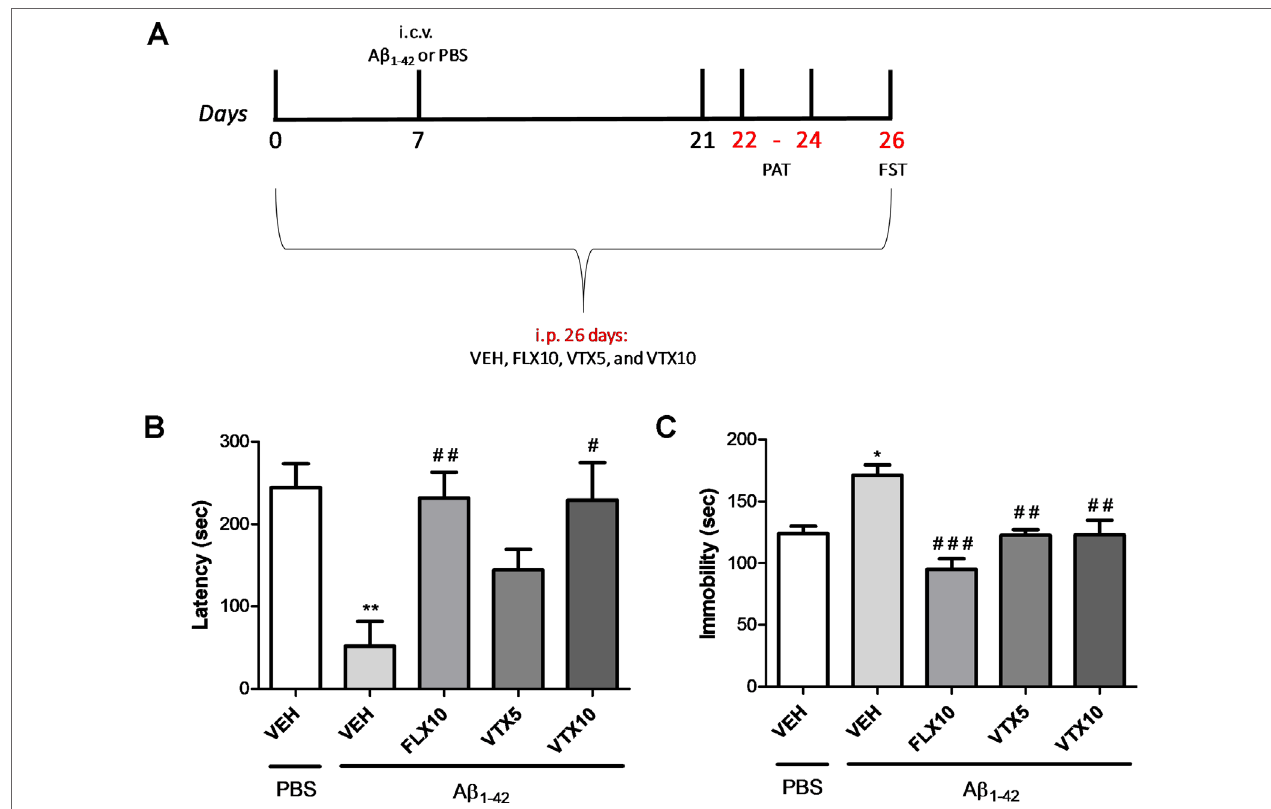
FIGURE 2 | Vortioxetine decreases depressive-like behavior and memory impairment A β 1-42 -induced. Forced swim test (FST) and passive avoidance test (PAT) were used to evaluate depressive-like behavior and memory impairment, respectively. VEH, FLX10, VTX5, and VTX10 were administered chronically for 26 days. Sterile PBS or A β 1-42 was administered i.c.v. 7 days after the first i.p. injection. i.c.v. = intracerebroventricular injection. (A) Schematic representation of the experimental design. (B) Latency time to re-enter the dark box during the retention test is expressed in seconds. (C) Immobility time measures are expressed in seconds. PBS + VEH ( n = 8), A β 1-42 + VEH ( n = 5), A β 1-42 + FLX10 ( n = 7), A β 1-42 + VTX5 ( n = 7), and A β 1-42 + VTX10 ( n = 6). FST and PAT were performed on the same experimental animal groups. Data are shown as mean ± SEM. * p < 0.05, ** p < 0.01 vs. PBS + VEH; # p < 0.05, ## p < 0.01, ### p < 0.001 vs. A β 1-42 + VEH; F (4,28) = 10.44 for (B) and F (4,28) = 5.59 for (C)